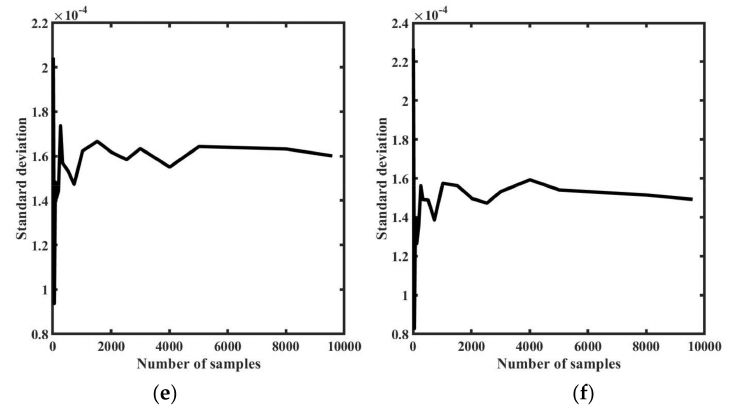
Figure 16. ( a , b ) represent the convergence of standard deviation with the increase in sample size at x = 15 mm and 45 mm for x strains, respectively, whereas ( c , d ) represent the y strains at x = 15 mm and 45 mm. Similarly, ( e , f ) represent the convergence plots for z strains at x = 15 mm and 45 mm respectively.